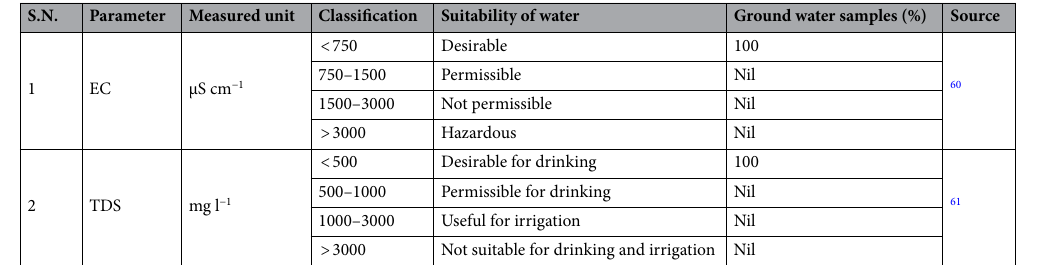
Table 6. Classification of water type and its suitability based on EC and TDS values (N = 72) 59 .